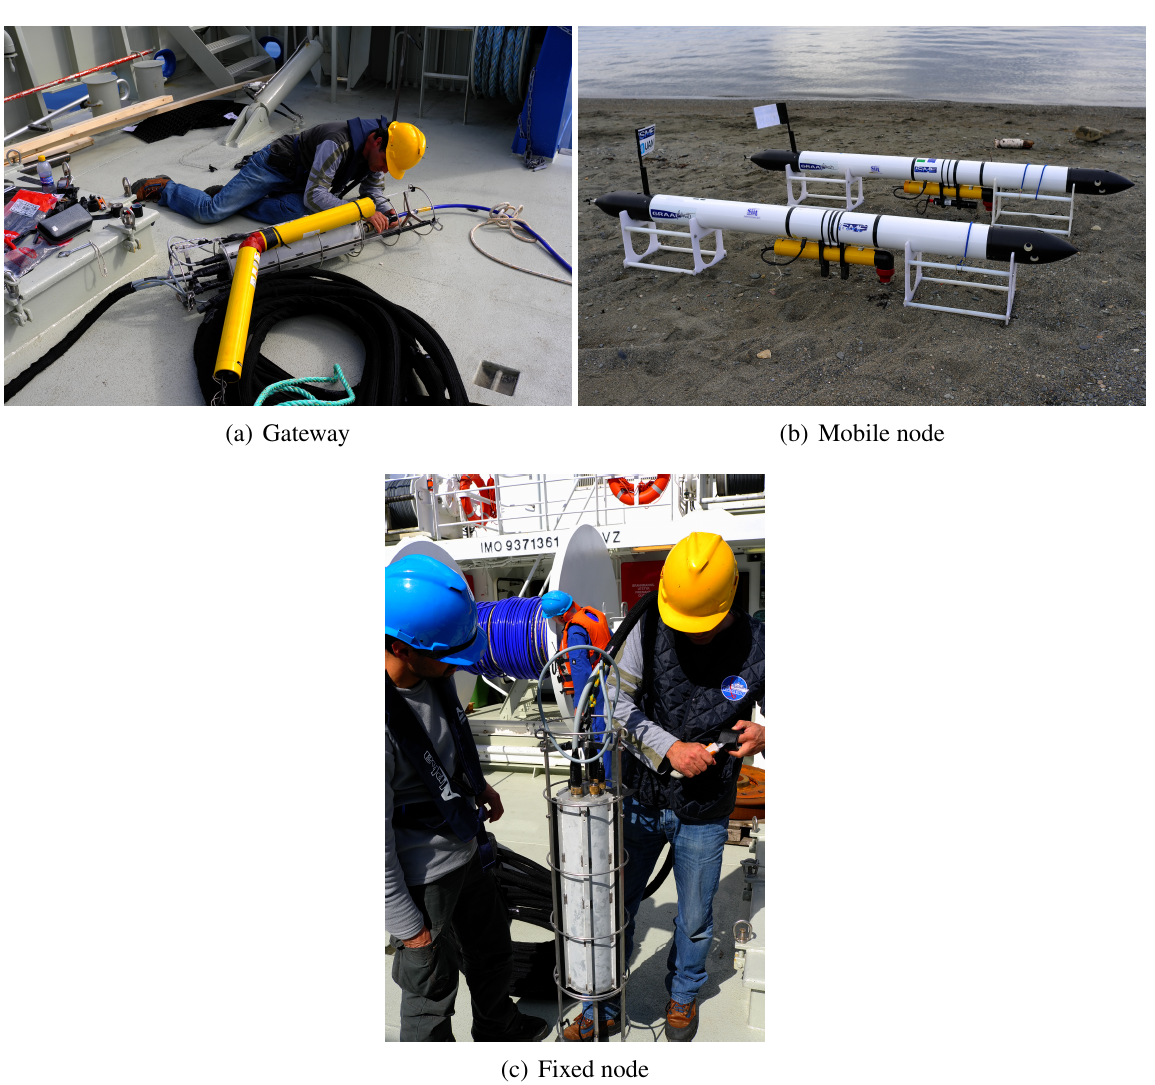
Figure 9. The nodes used in the